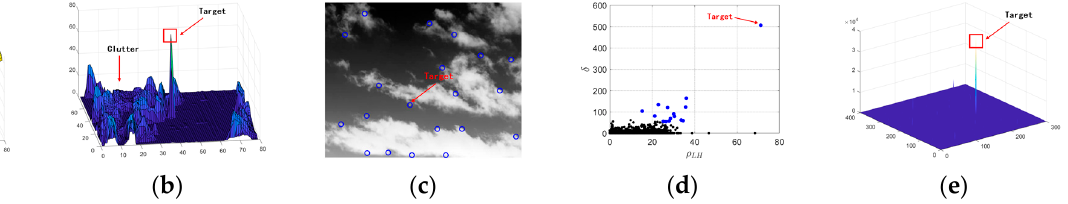
Figure 3. Detection results of Figure 1a. ( a ) 3D schematic diagram of the local image around the target; ( b ) The processing result of LHI; ( c ) Results of new density peaks searching; ( d ) The position of the target point in ρ – δ space; ( e ) The value of density peaks clustering index γ .